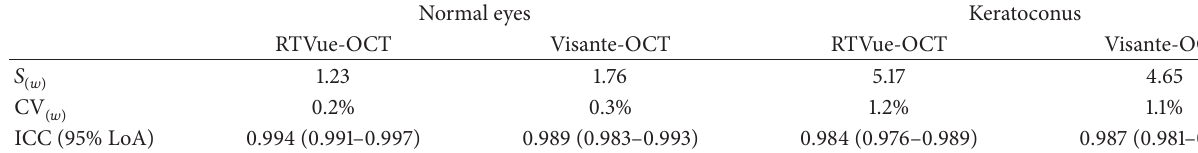
Table 2: Analysis of intraobserver repeatability of each OCT for normal and keratoconic eyes. Normal eyes